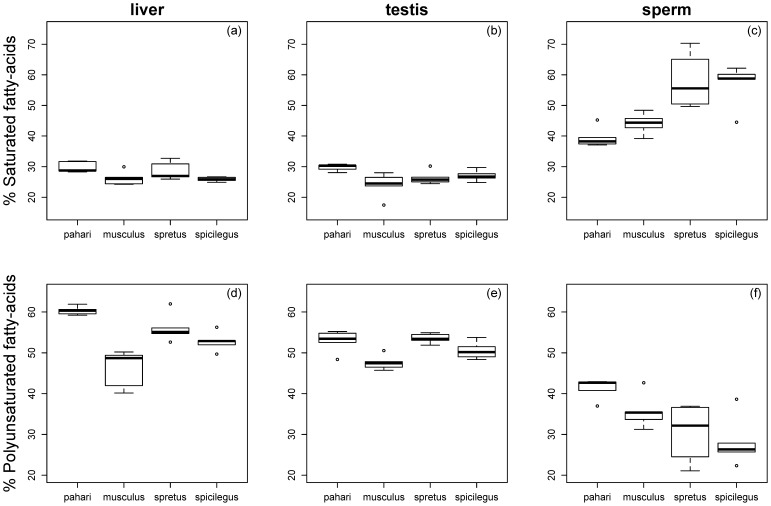
Percentage of saturated and polyunsaturated fatty acids.The percentage of saturated fatty acids (A–C) and polyunsaturated fatty acids (D–F) are shown for liver, testis and sperm. The modified boxplots present the following information: the bar within each box represents the sample median, each box represents 50% of the data around the median, and the two whiskers around each box represent the 95% confidence interval (n = 5 for each species, except n = 4 in the case of sperm data for M. spretus); circles represent outliers.